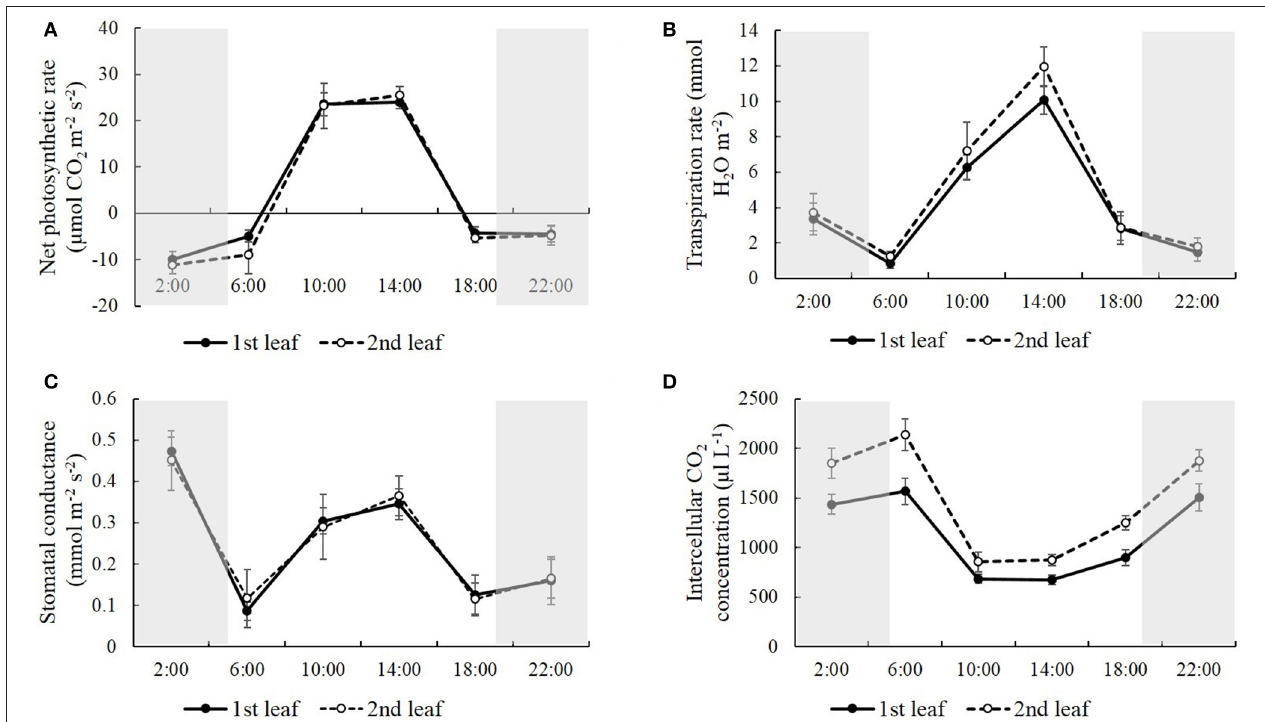
FIGURE 1 | The net photosynthetic rate (A), transpiration rate (B), stomatal conductance (C), and intercellular CO 2 concentration (D) in the first and second leaves from the top of the rice plant at the time of 2:00, 6:00, 10:00, 14:00, 18:00, and 22:00. Values are mean ± SD from 10 randomly selected plants.